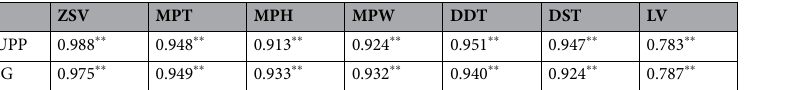
Table 3. Correlation coefficients between UPP, IG and the gluten, dough and breadmaking quality parameters of the samples collected from five environments. DDT, dough development time; DST, dough stability time;